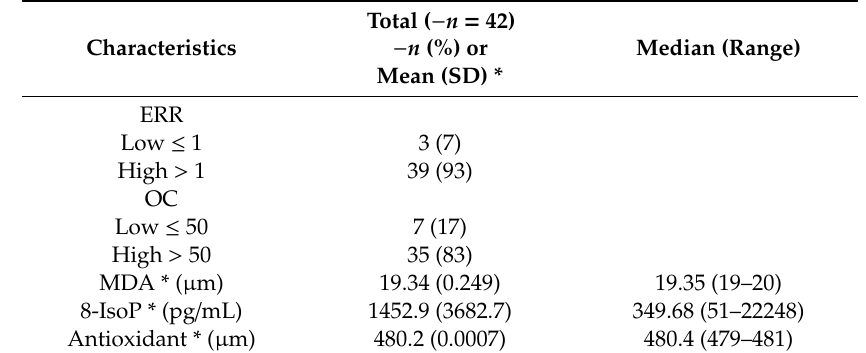
Table 2. Characteristics of exposures (ERR, OC) and outcomes (oxidative biomarkers) in the study